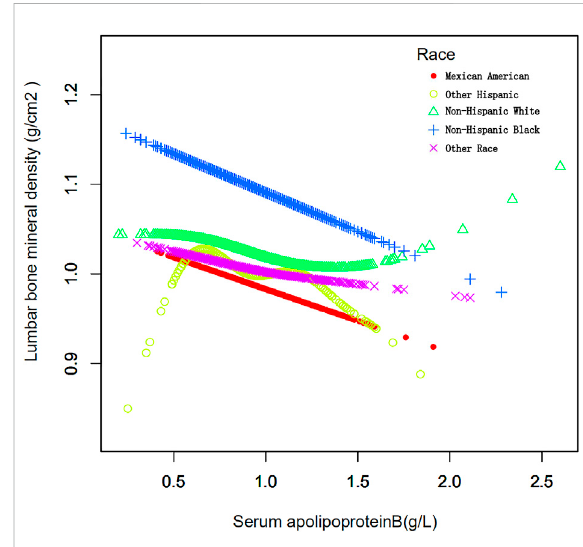
FIGURE 5 Association between serum apolipoprotein B and lumbar bone mineral density strati fi ed by race. Age, race/ethnicity, sex, vigorous recreational activities, smoked at least 100 cigarettes in life, income to poverty ratio, blood urea nitrogen, serum calcium, serum potassium, serum sodium, serum phosphorus, total protein, serum uric acid, body mass index were adjusted.